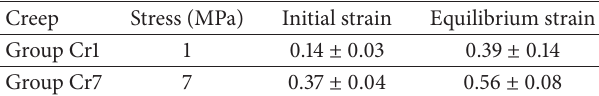
Table 2: Average values obtained from creep tests.